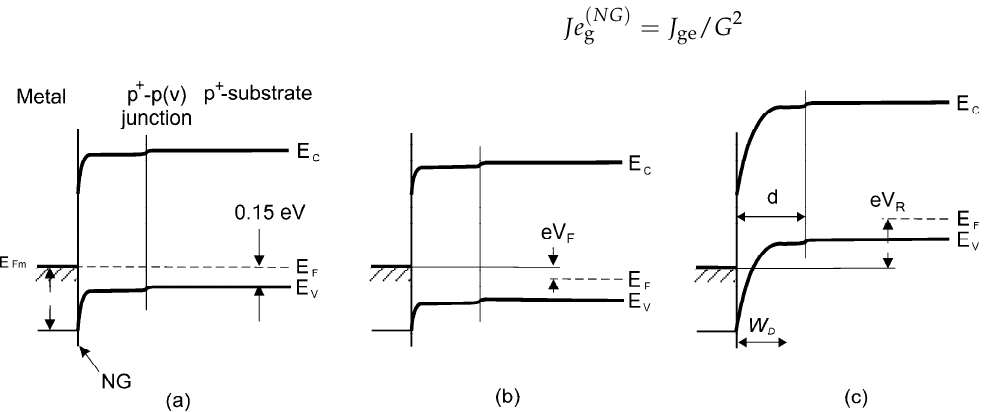
Figure 7. Energy-band diagram for p-p(v)-M junction. ( a ) Thermal equilibrium; ( b ) forward bias; ( c ) reverse bias. Distances and energies (except eV R ) are scaled according to their experimental values.